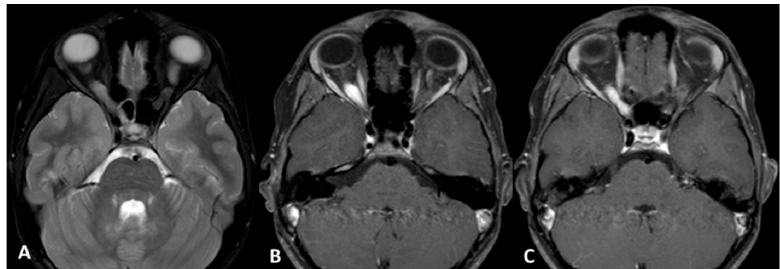
Figure 1. Optic glioma 1Aright (Subject 12 OPG). Orbit MRI. ( A ) Axial T2-weighted images (w.i.) with fat suppression; ( B , C ) Axial T1 w.i. with fat suppression and after gadolinium administration show